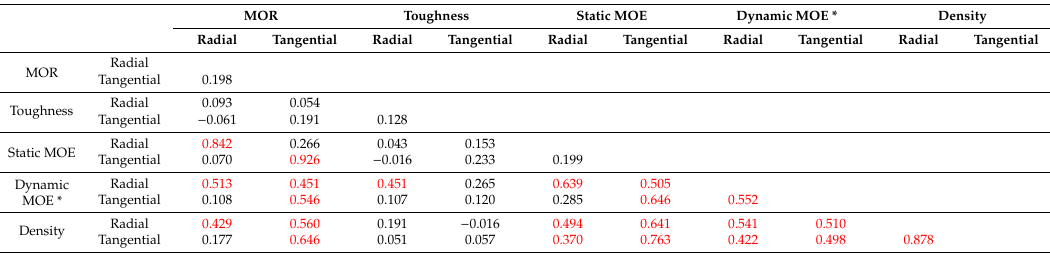
Table A8. Values of Correlation Coe ffi cients Between Given Quantities for Linden Wood. MOR